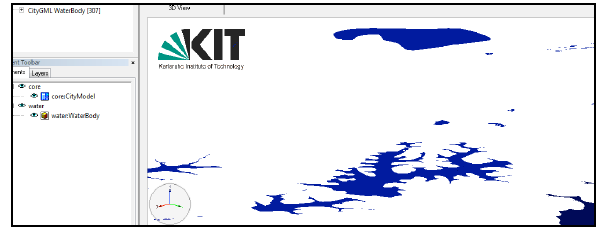
Figure 11. LOD 1 WaterBody